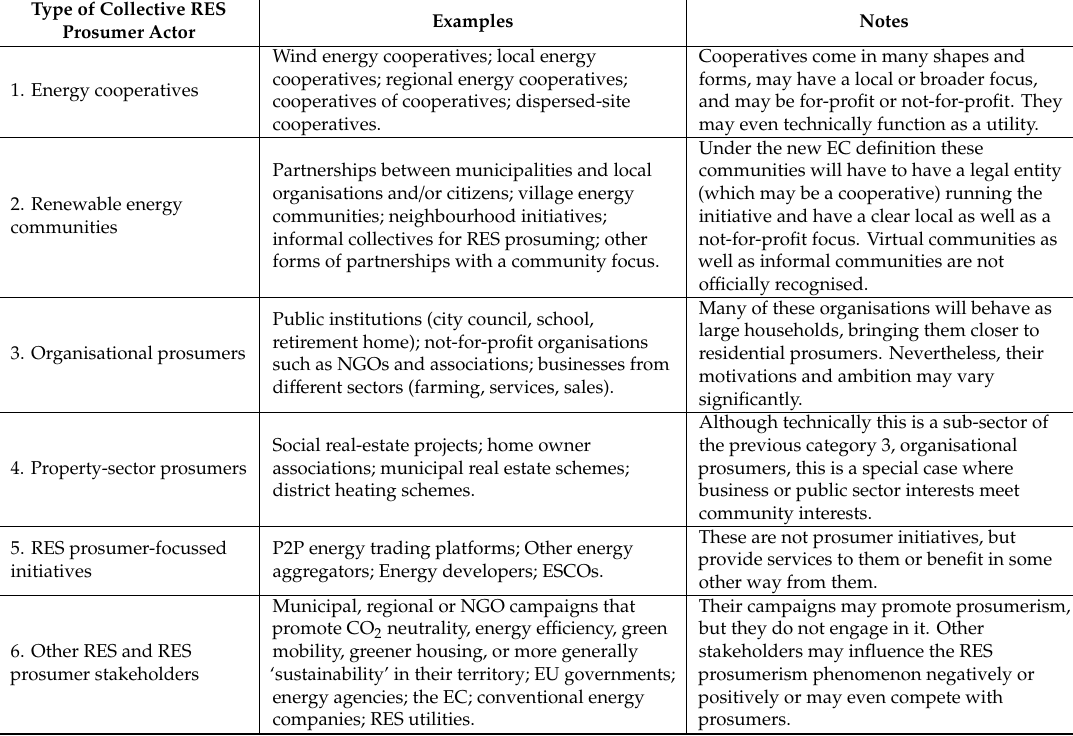
Table 2. Key categories of collective RES prosumer actors. Source: [23] (pp.